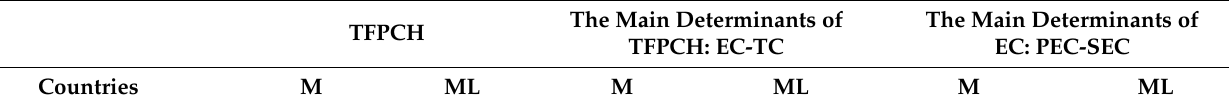
Table 6. Determinants of TFPCH index before and after the inclusion of undesirable output in the initial